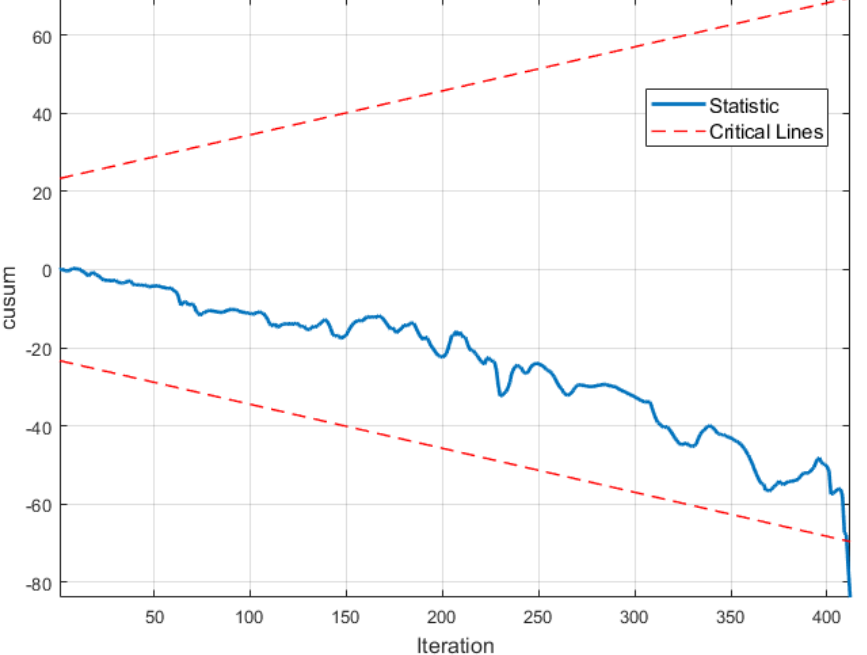
Figure 8. Monitoring and diagnosis results of the abnormal operating state F1 using CUSUM test statistics.